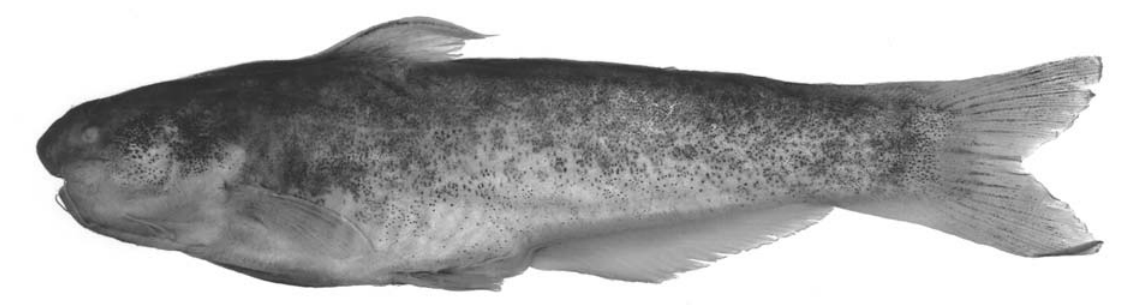
Fig. 38 . Cetopsis plumbea, MEPN 1529, 78 mm SL; Ecuador, Zamora-Chinchipe, Playa del río Nangaritza, approximately 5 km upriver of Paguisha and Playa de Mayayacu Bajo (3°59’S, 78°36’W) .